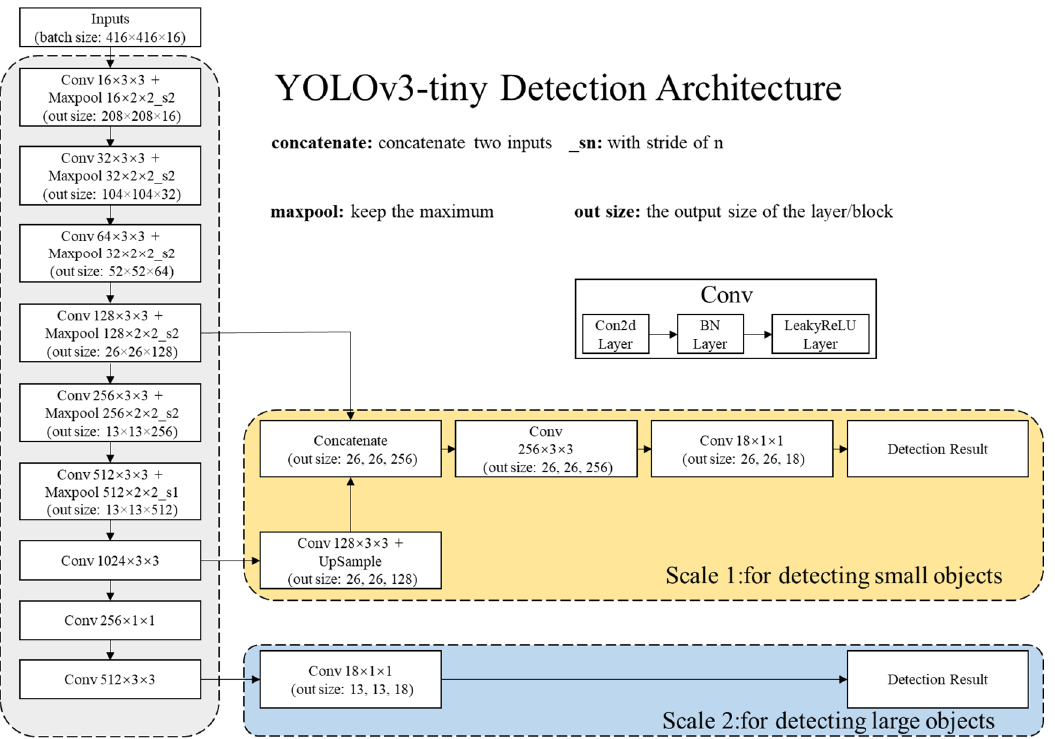
Figure 3. YOLOv3–tiny detection architecture.